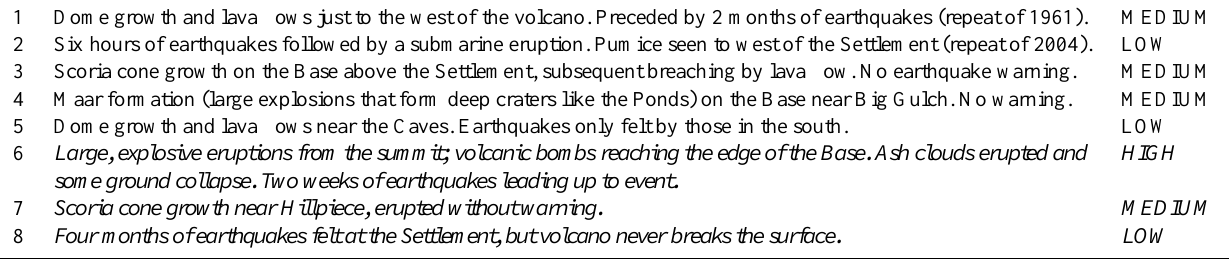
Table 4. Eight scenarios presented for deliberation at the planning workshop. Each scenario has a relative risk level which was allocated by acknowledging the size of the eruption in the scenario, proximity to the Settlement, speed of onset, quantity and type of precursory signs and signals. Volcanological terminology (e.g. scoria cone) were introduced at the first council meeting. Use of the term “the volcano” was used to reflect locally accepted terminology for the 1961–1962 eruption, and just “volcano” for an eruption. Chosen scenarios to “play out” are in italic. 1 Dome growth and lava flows just to the west of the volcano. Preceded by 2 months of earthquakes (repeat of 1961). Six hours of earthquakes followed by a submarine eruption. Pumice seen to west of the Settlement (repeat of 2004). Scoria cone growth on the Base above the Settlement, subsequent breaching by lava flow. No earthquake warning. 4 Maar formation (large explosions that form deep craters like the Ponds) on the Base near Big Gulch. No warning. 5 Dome growth and lava flows near the Caves. Earthquakes only felt by those in the south. Large, explosive eruptions from the summit; volcanic bombs reaching the edge of the Base. Ash clouds erupted and HIGH some ground collapse. Two weeks of earthquakes leading up to event. Scoria cone growth near Hillpiece, erupted without warning. Four months of earthquakes felt at the Settlement, but volcano never breaks the